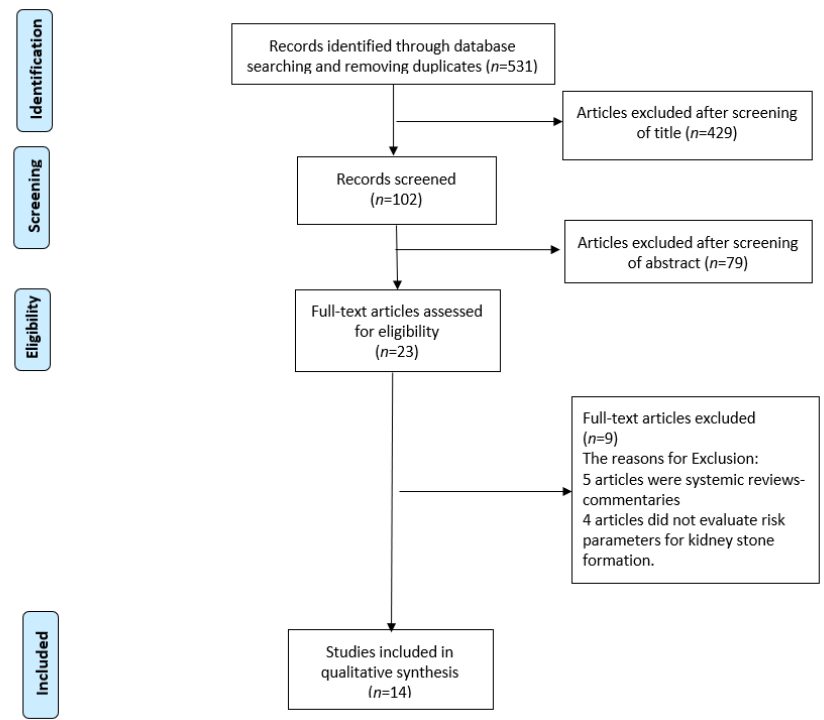
Figure 1. PRISMA flowchart of the included studies.